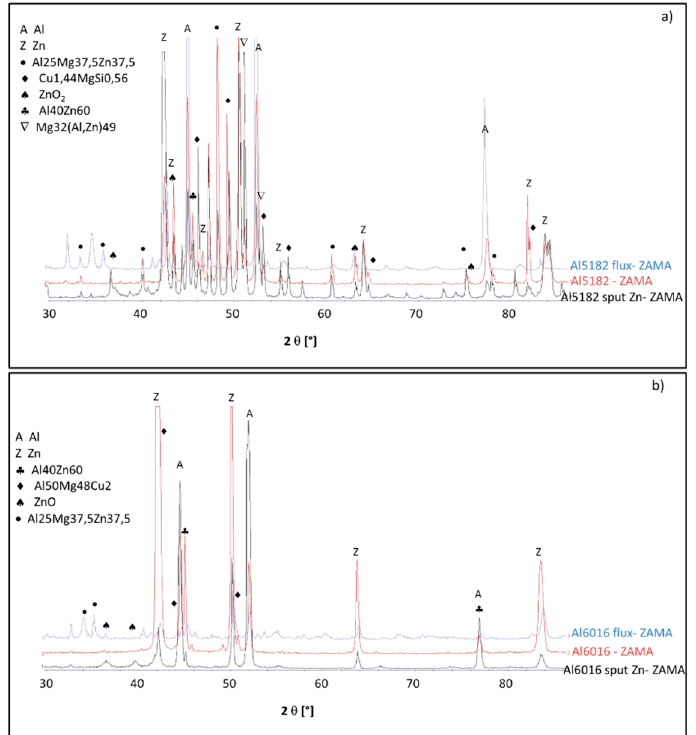
Figure 5. XRD spectra of the top surface of samples after the “spreading test”. (ZAMA as brazing material.): ( a ) Al 5182 substrate; ( b ) Al 6016 substrate. material.): ( a ) Al 5182 substrate; ( b ) Al 6016